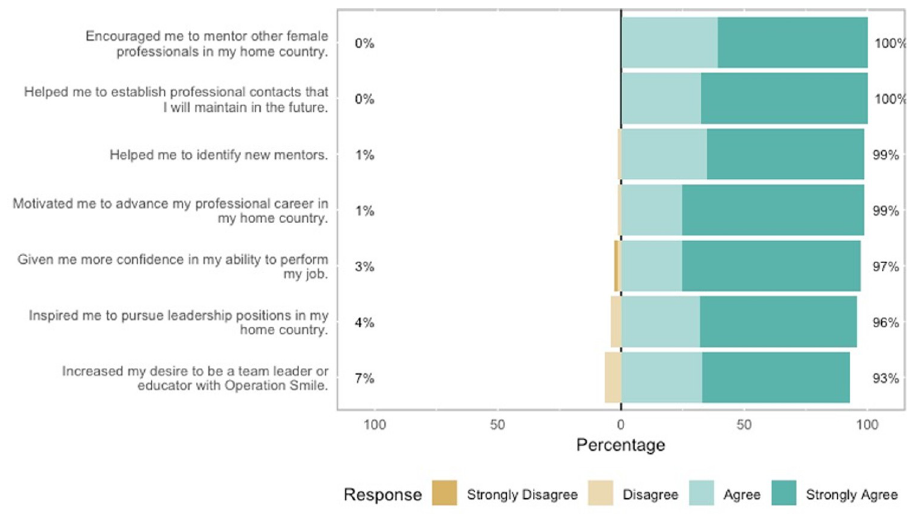
Fig 5. Opinions on mentorship and leadership after the women’s